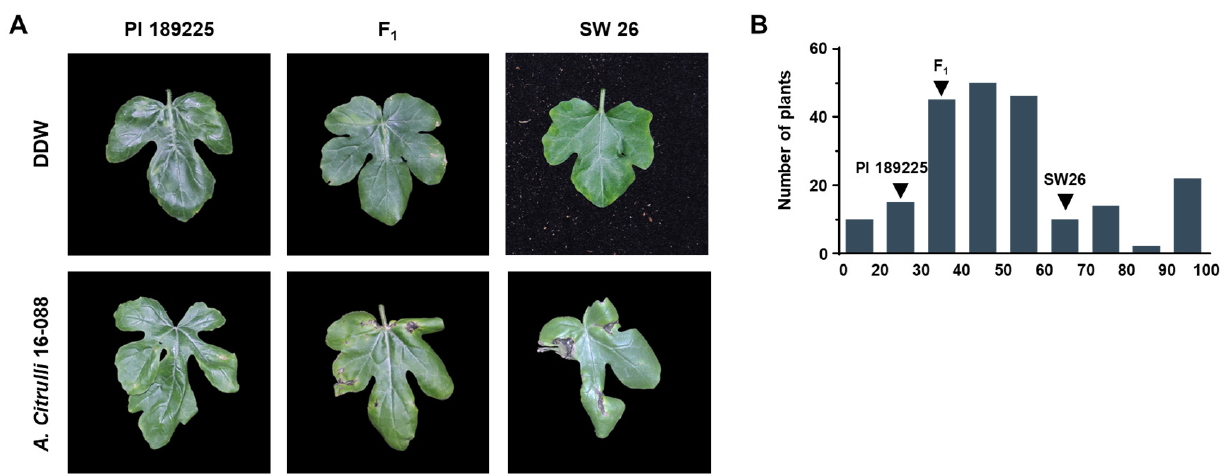
Figure 2. ( A ) Phenotype of the resistant (PI 189225), susceptible (SW 26), and their F 1 (SW 26 × PI 189225) 14 days after inoculation (DAI) with DDW or A. citrulli strain 16-088. ( B ) Frequency distribution for percent disease index (PDI) at 14 DAI with strain 16-088 in the SW 26 × PI 189225 watermelon F 2 population ( n = 214). PI 189225, SW 26, and F 1 population showed mean values ( n = 10).